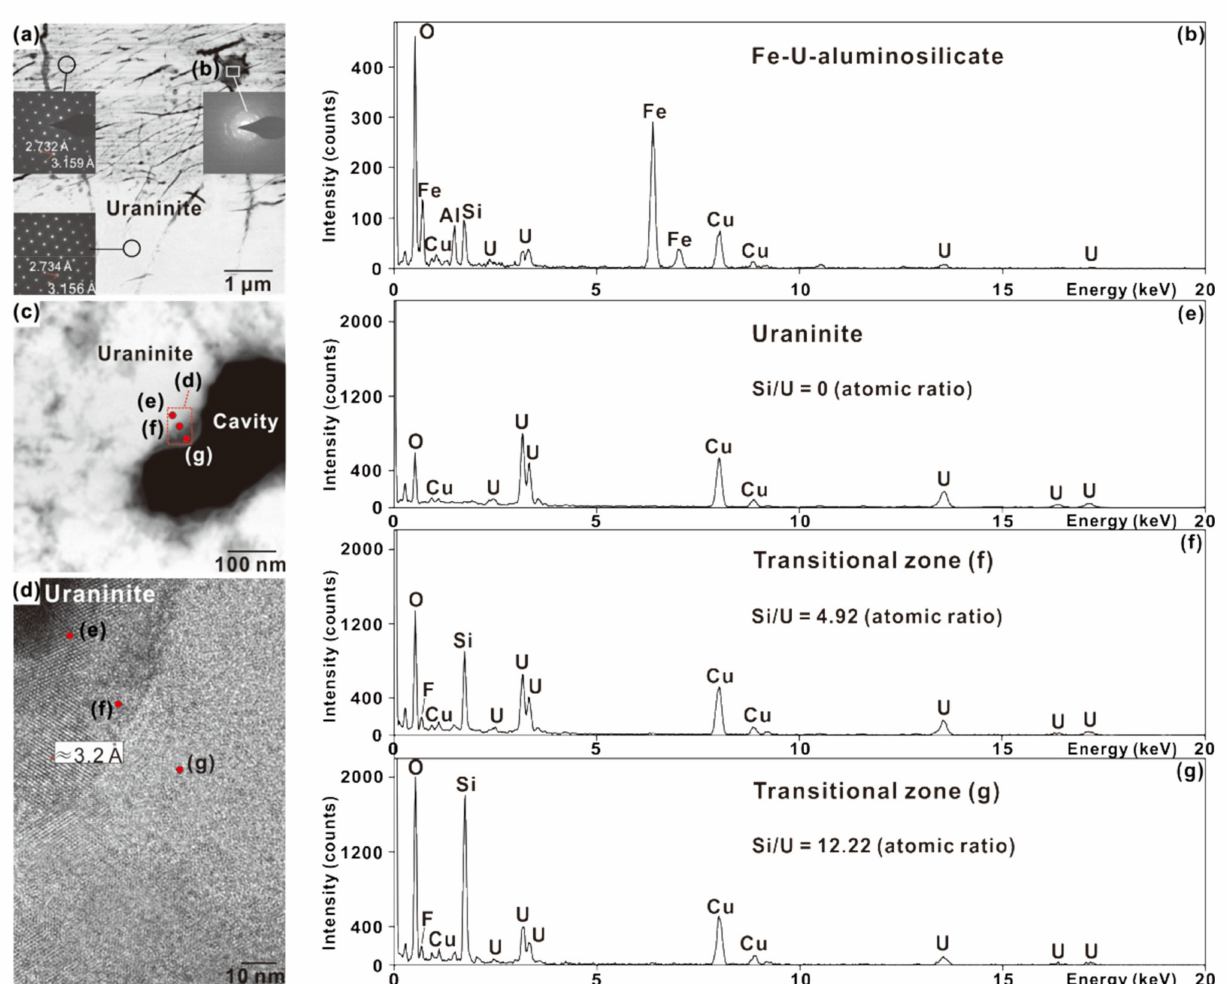
Figure 7. TEM images of transitional zones between the non-altered and altered part of uraninite in Figure 6b. ( a , b ) HAADF- STEM image, SAED patterns and EDX analysis show the well-crystalline main body of uraninite and a polycrystalline, potential Fe-U-rich aluminosilicate inclusion at the beginning of alteration. ( c – g ) HAADF-STEM and FFT of HRTEM images further show that uraninite is becoming more amorphous towards edges or cavities with increasing Si/U ratios by EDX analyses. Of note, d-spacing of 3.2 Å in ( f ) is close to that of well-crystalline uraninite in ( a ). Signal of Cu in EDX is from copper grid, rather than from the